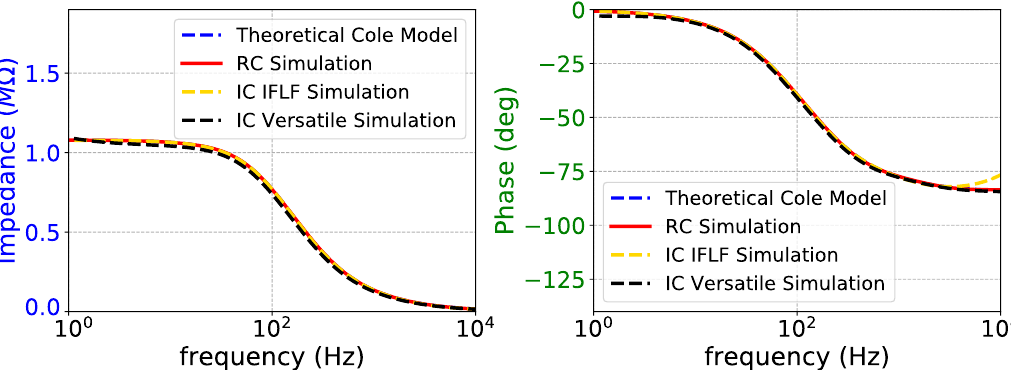
Figure 13. Impedance magnitude ( left ) and phase response ( right ) of fractional-order electrode